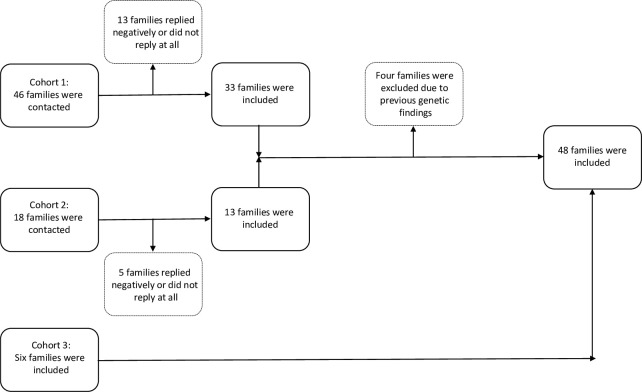
Flow chart illustrating the inclusion of patients.Cohort 1 comprises families previously genetically counselled. Cohort 2 comprises patients identified through the Danish Cancer Registry. Cohort 3 comprises one family identified through the clinical setting at Copenhagen University Hospital and five families identified from another study in the research group.